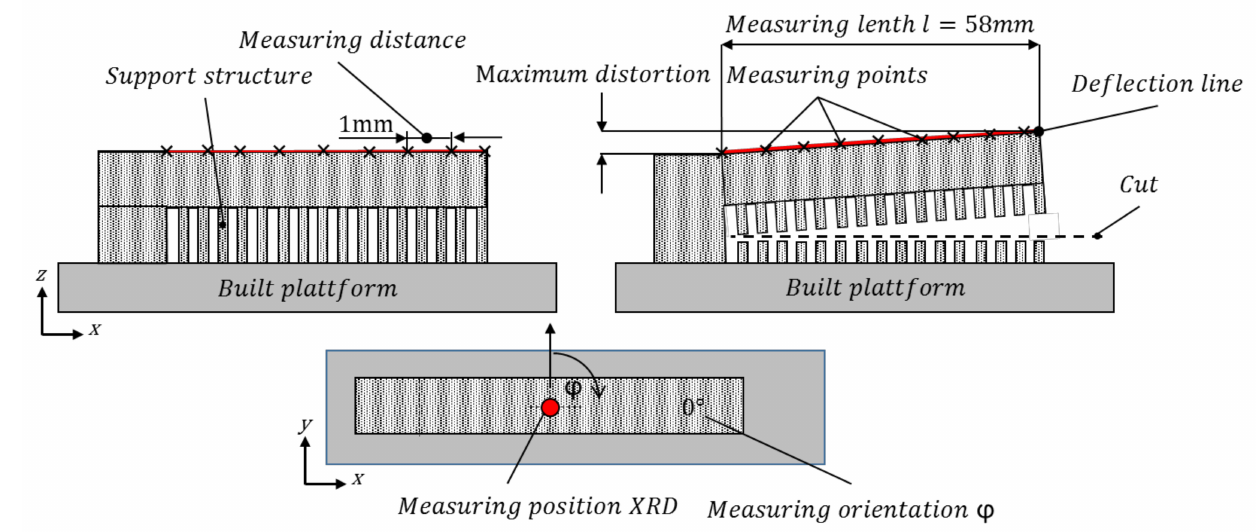
Figure 7. Schematic illustration of the measuring strategy of the surface profile height and the measur- ing position and orientation of the internal stress by X-ray diffraction on the used cantilever